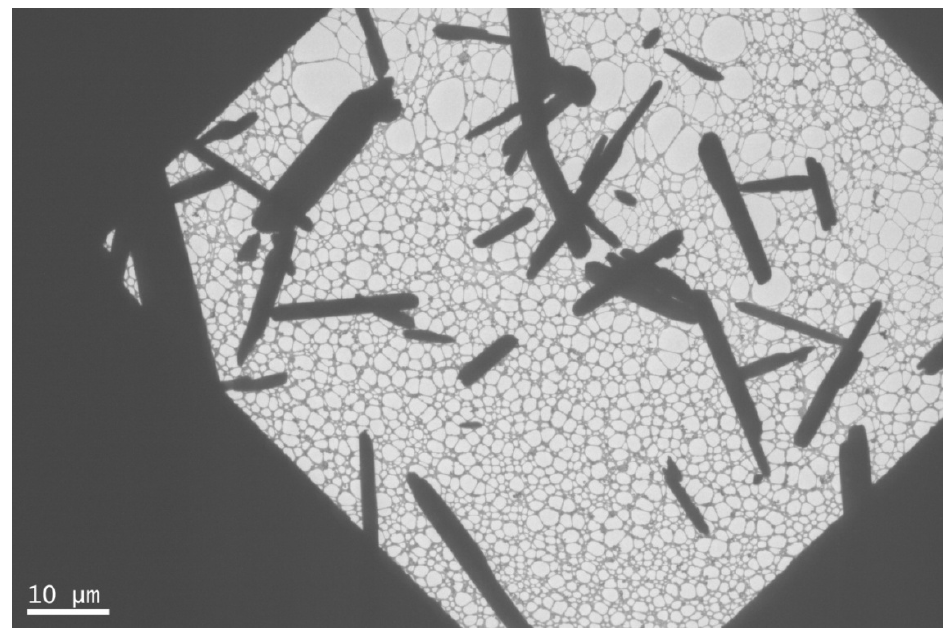
Figure 7. TEM image of sliver oxide